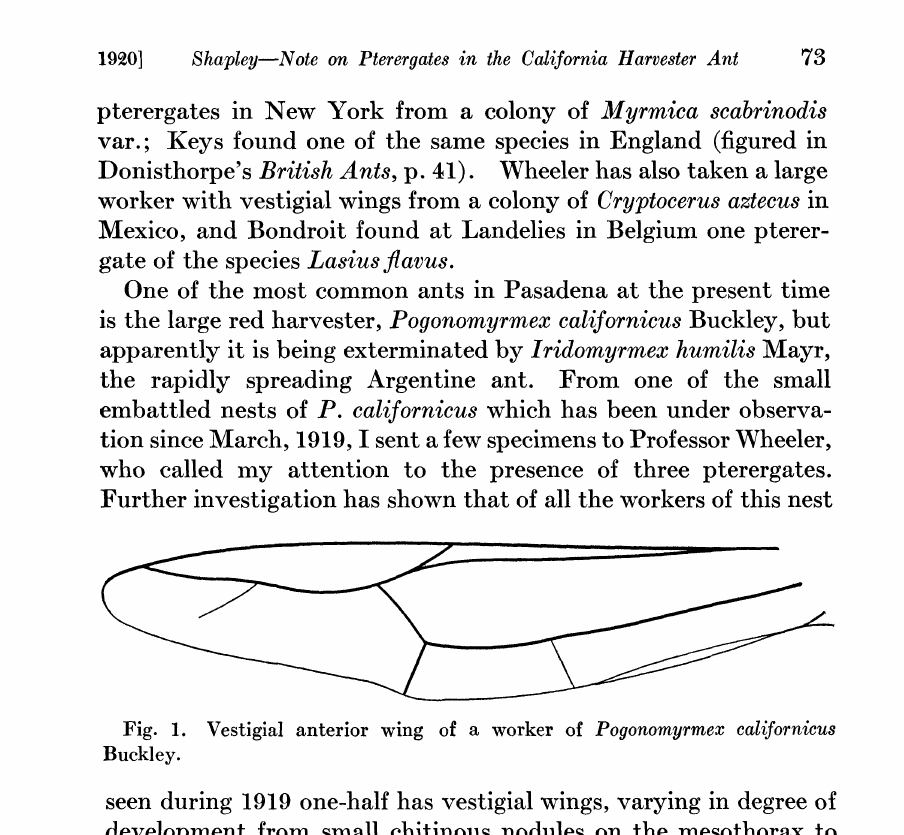
Fig. 1. Vestigial anterior wing of a worker of Pogonomyrmex californicus Buckley. seen during 1919 one-half has vestigial wings, varying in degree of membranous structures one to two millimeters in